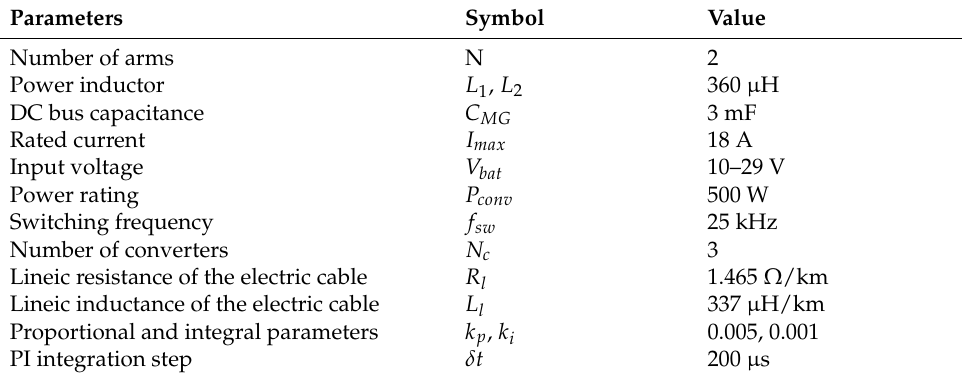
Figure 22. Lab prototype of the converter. Table 2. Parameters of the developed converter and test